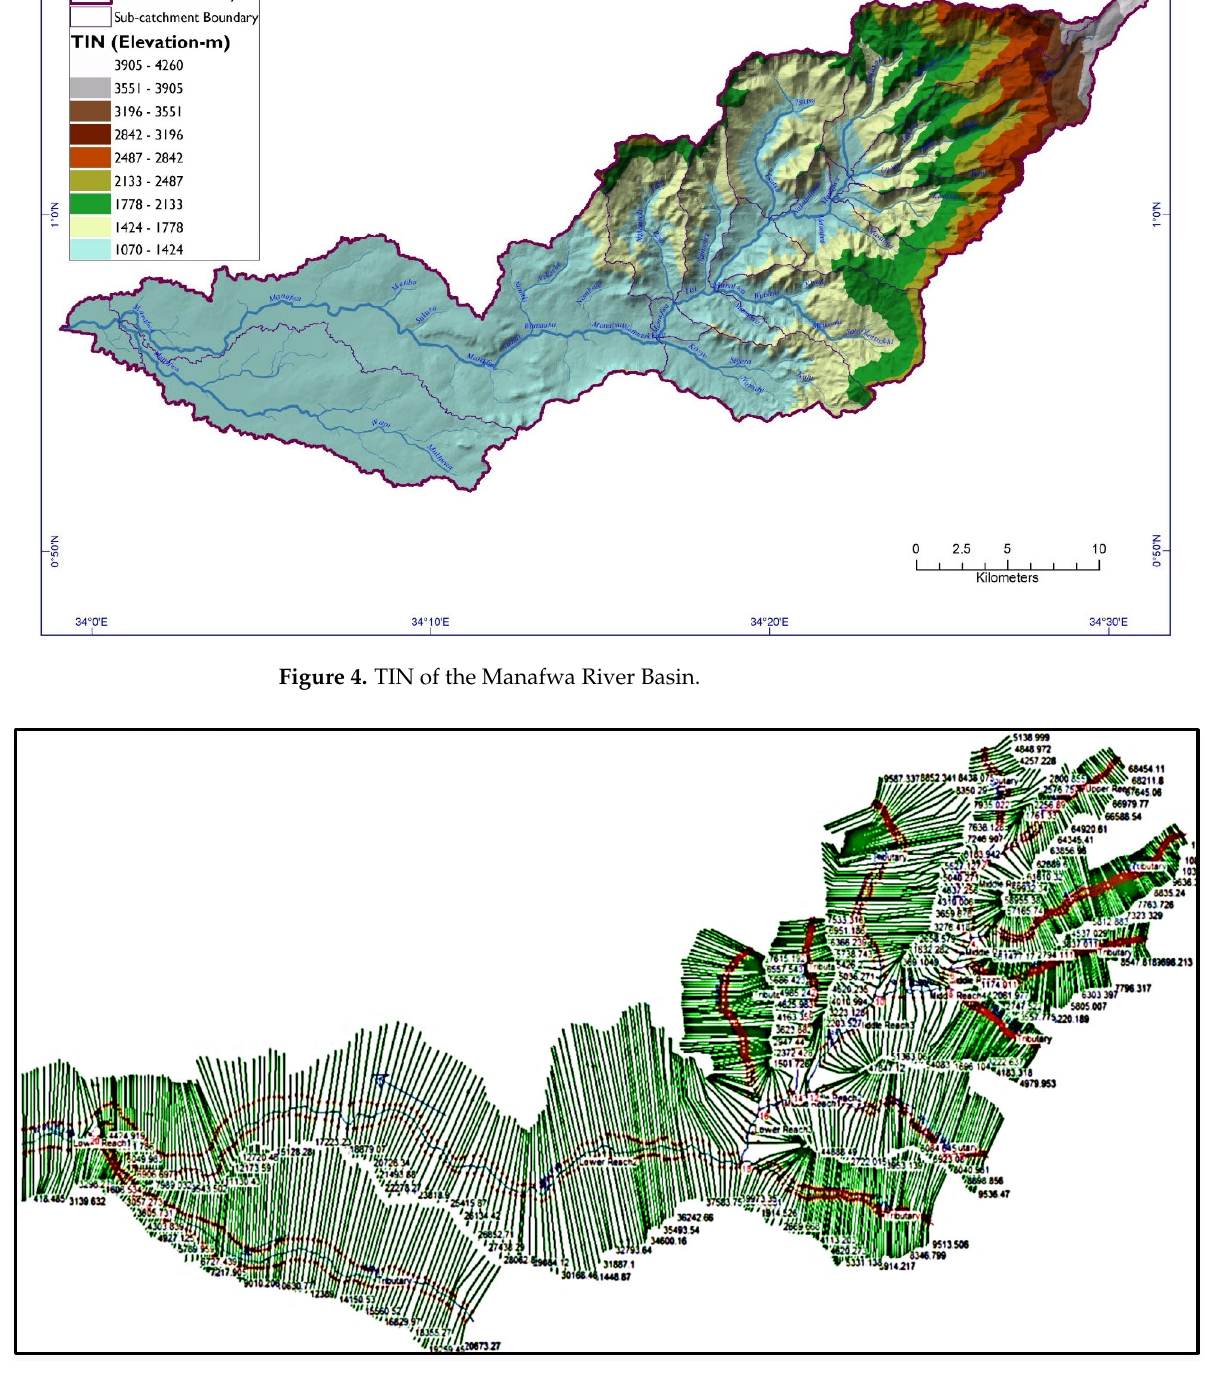
Figure 5. Schematic view of the geometry of study river.